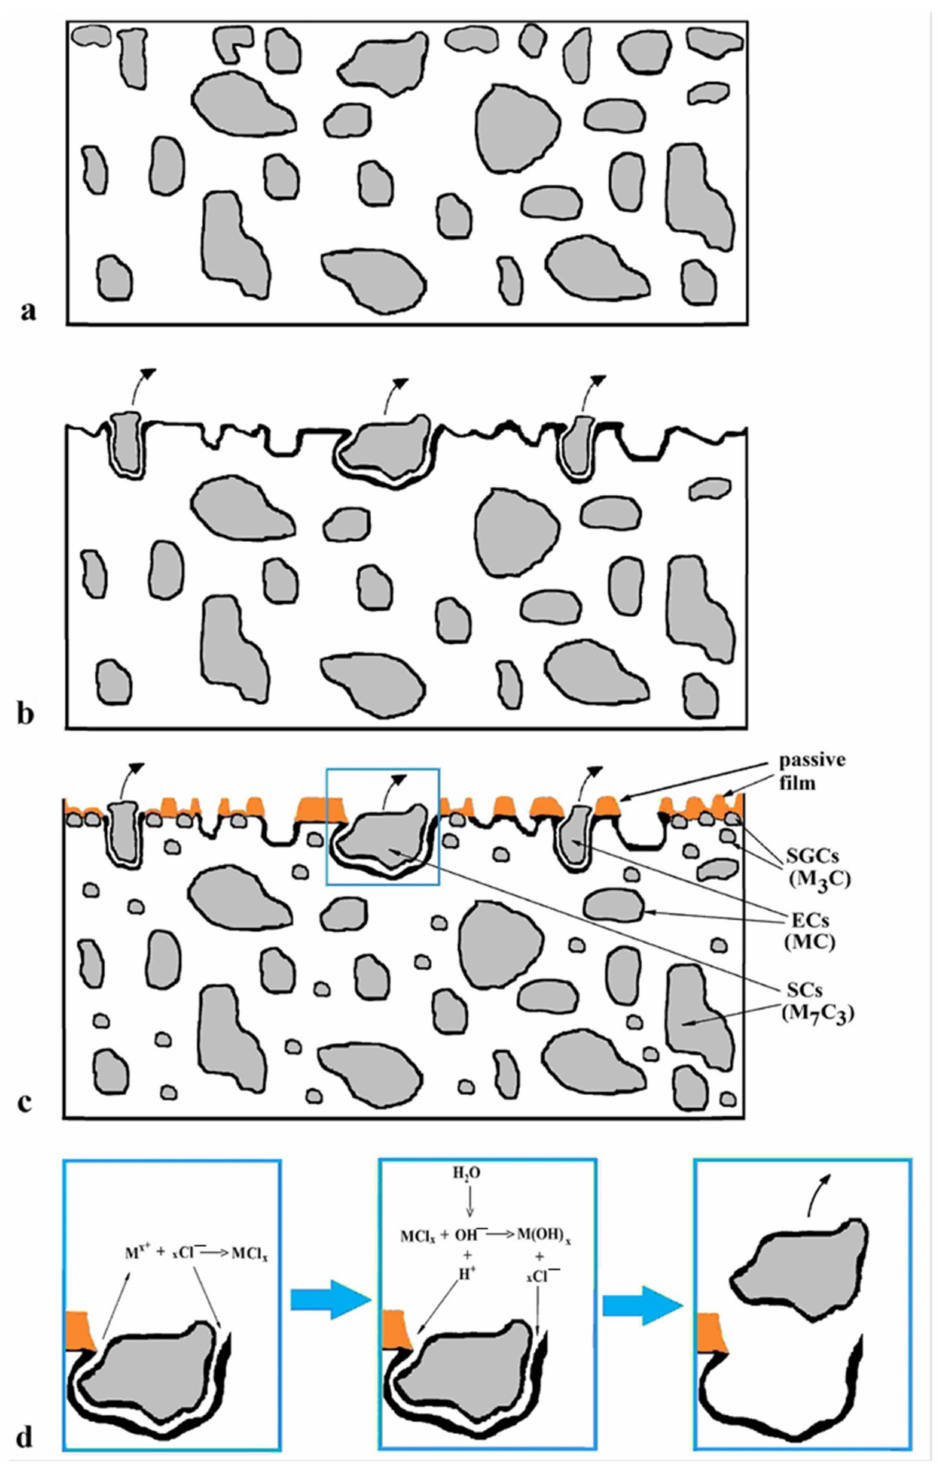
Figure 16. A schematic of the corrosion attack of the Vanadis 6 steel: before testing ( a ), after testing, CHT steel ( b ), SZT steel—overview ( c ), detail from ( d